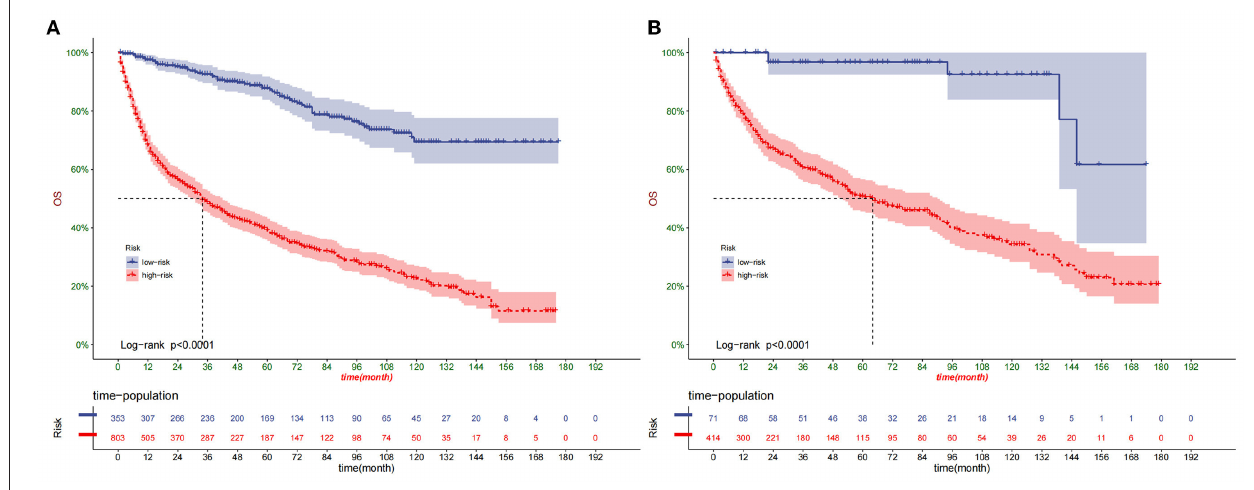
FIGURE 6 | Kaplan–Meier curves of OS for patients in the low- and high-risk groups in the training set (A) and validation set (B) .